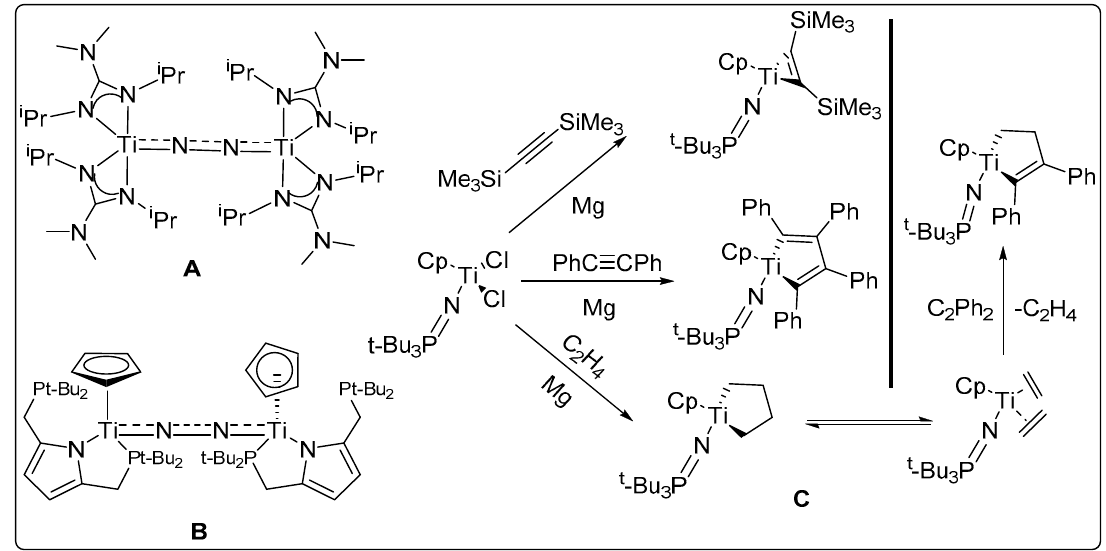
Figure 2. ( A ) An example of a Ti(II) dinitrogen adduct by Bergman and Arnold [31] ( B ) by Nishibayashi [32] and ( C ) examples of Ti(II) chemistry [32].